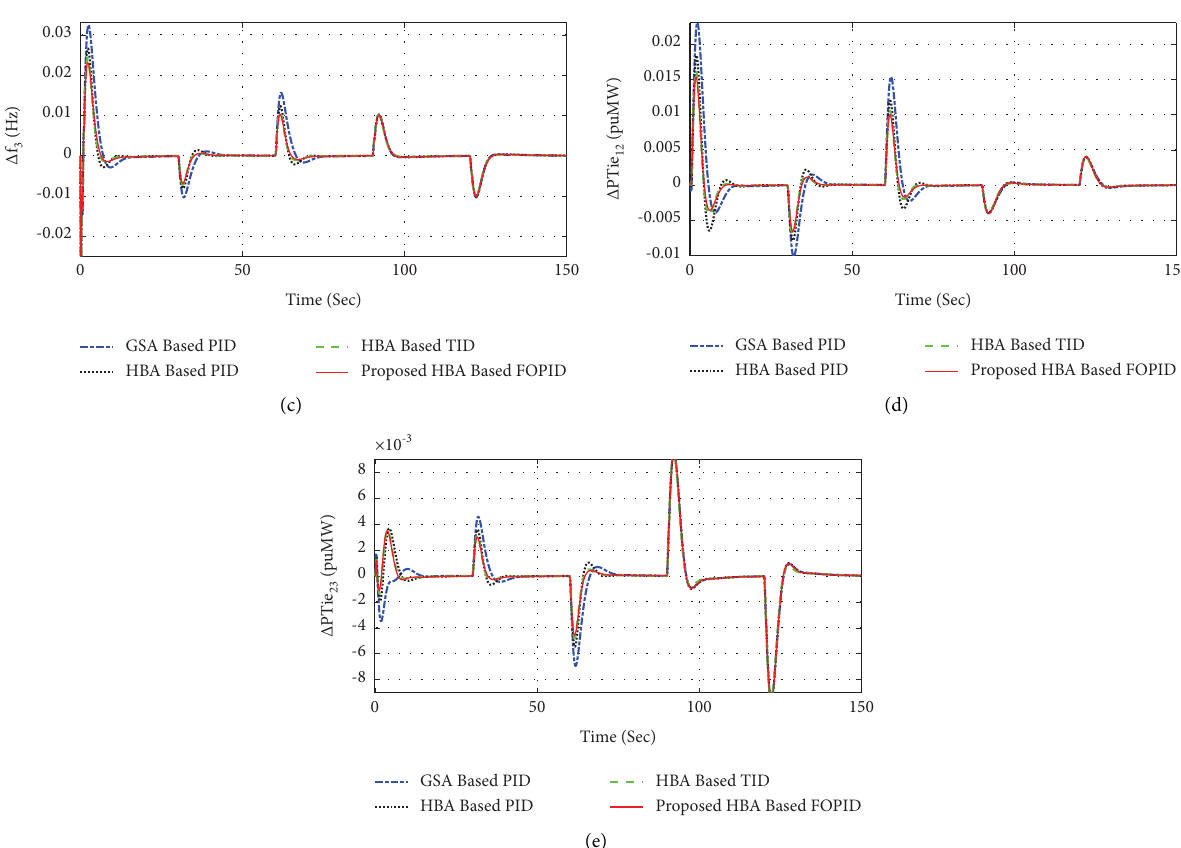
Figure 5: (a–e) System response for condition 1: (a) A